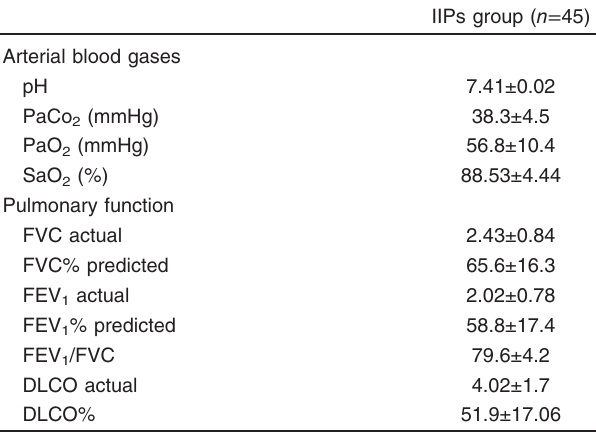
Table 2 Pulmonary function tests, arterial blood gas analysis Table 3 Prevalence of erectile dysfunction among male patients with idiopathic interstitial pneumonias